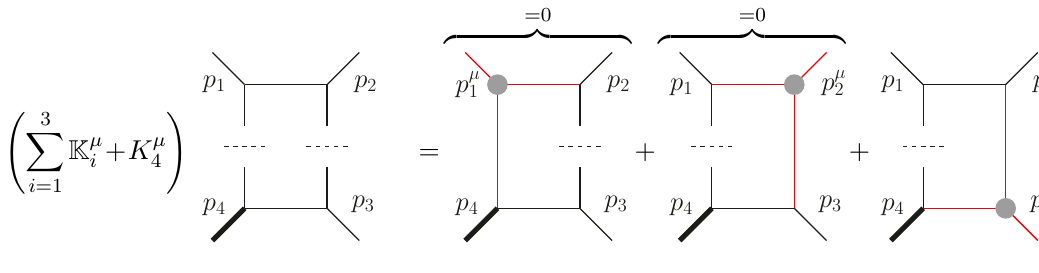
Figure 8 . Conformal Ward identity for the s -channel cut of the one-mass 6D box. The momenta of the highlighted lines are collinear. The (cid:12)rst two contributions vanish.